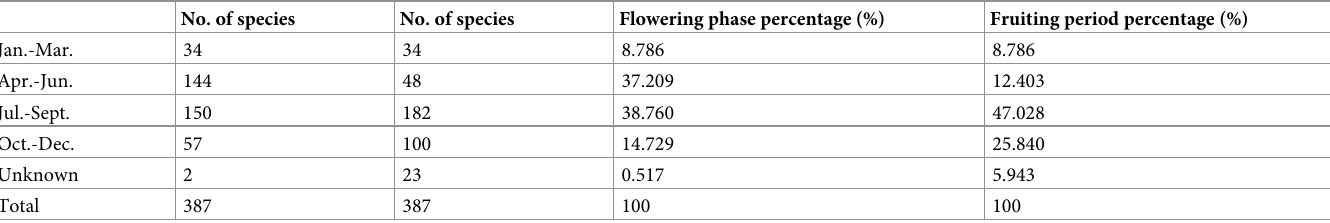
Table 3. Counts and percentages of flowering and fruiting periods of endemic plants in Hainan. No. of species No. of species Flowering phase percentage (%) Fruiting period percentage